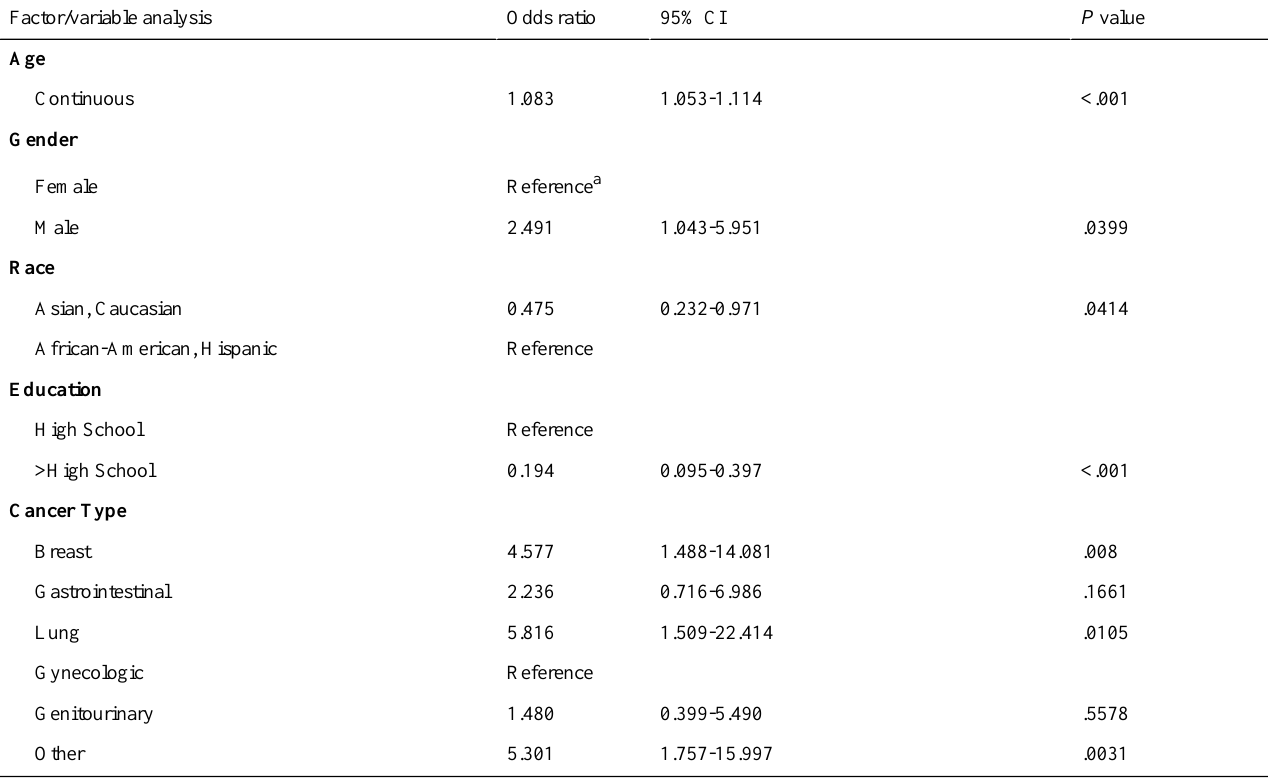
Table 2. Multivariate